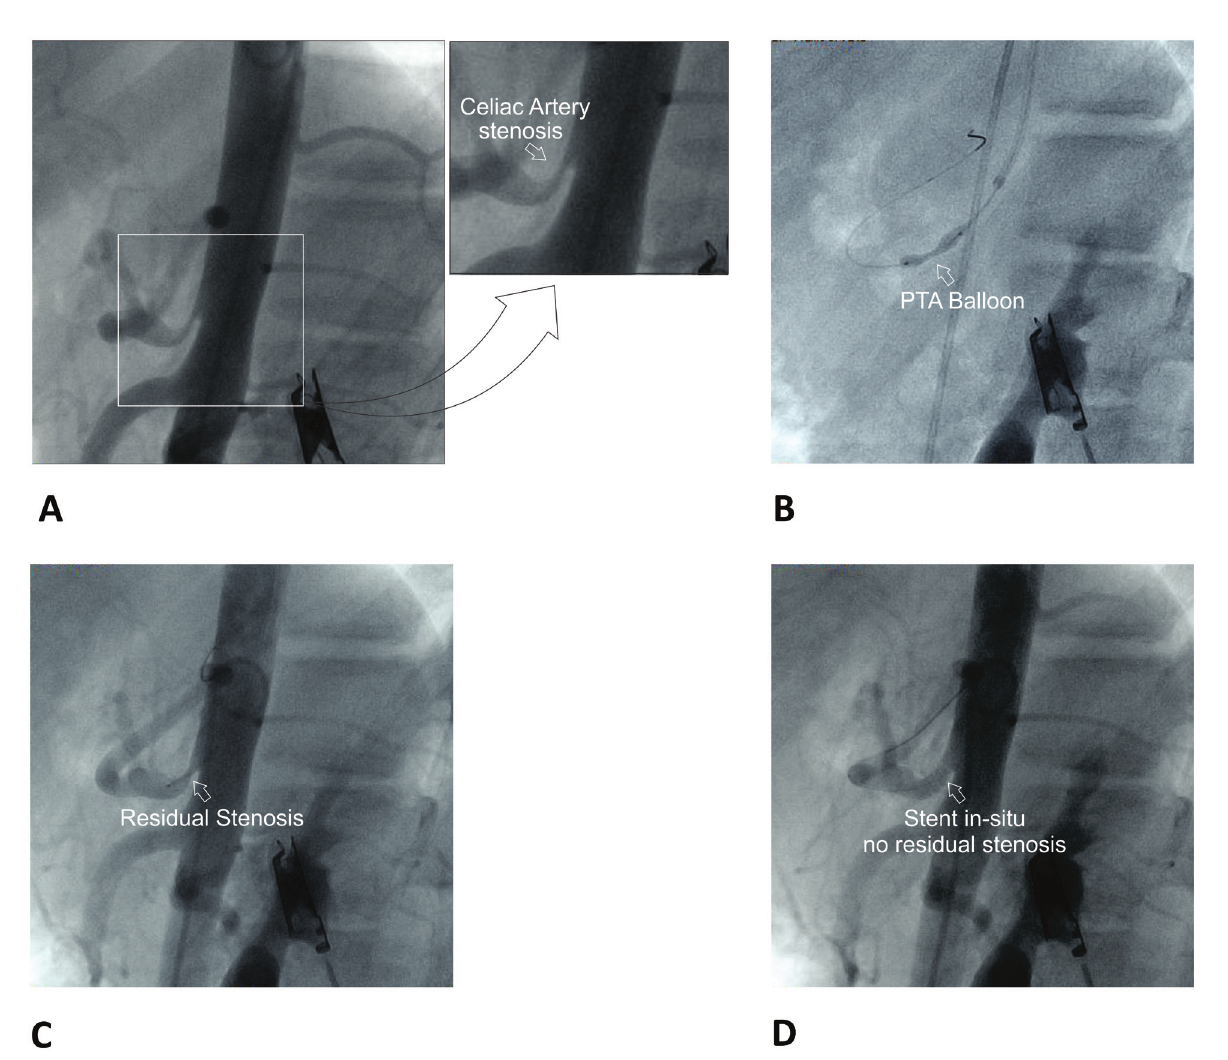
Figure 1. Percutaneous balloon angioplasty with stent placement for celiac artery stenosis. A . Non-selective angiography (lateral view) showing ostial and proximal segment stenosis of the celiac artery. (The inset shows a close-up view of the stenosis; arrow). B . PTA balloon inflated showing “waist” formation (arrow). C . Residual stenosis (arrow) after initial PTA. D . Stent in-situ with no residual stenosis